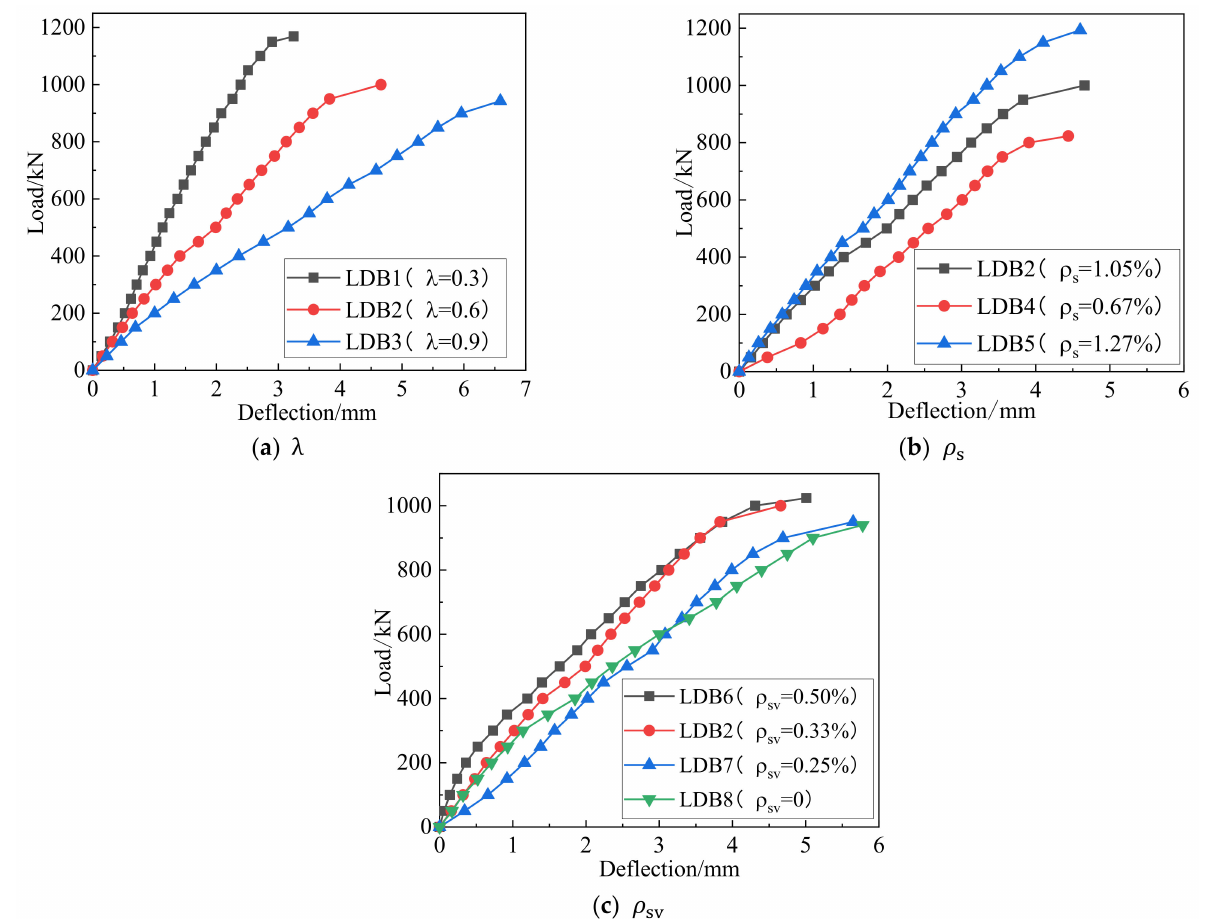
Figure 13. Relation curve between three variables and